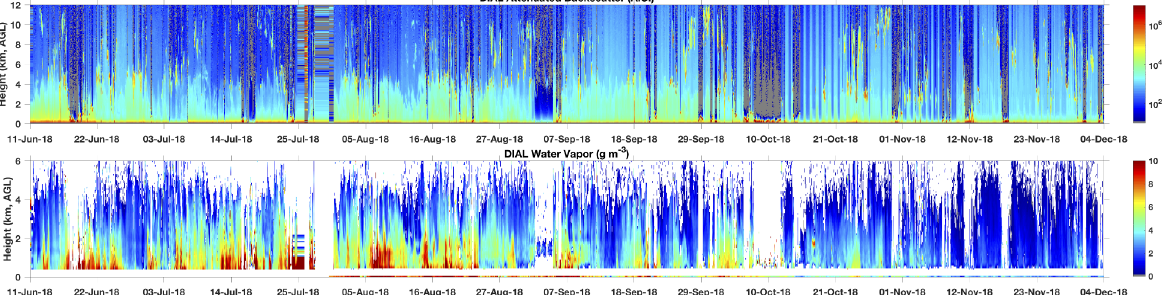
Figure 2. Time series of decimated 5-min 150-m MPD unit 3 profiles showing (top) range-corrected relative backscat- ter and (bottom) absolute humidity (gm − 3 ). Vertical white bars signify missing data due to MPD downtime from instrument testing periods (i.e., not hardware related) or attenuated signal above optically thick